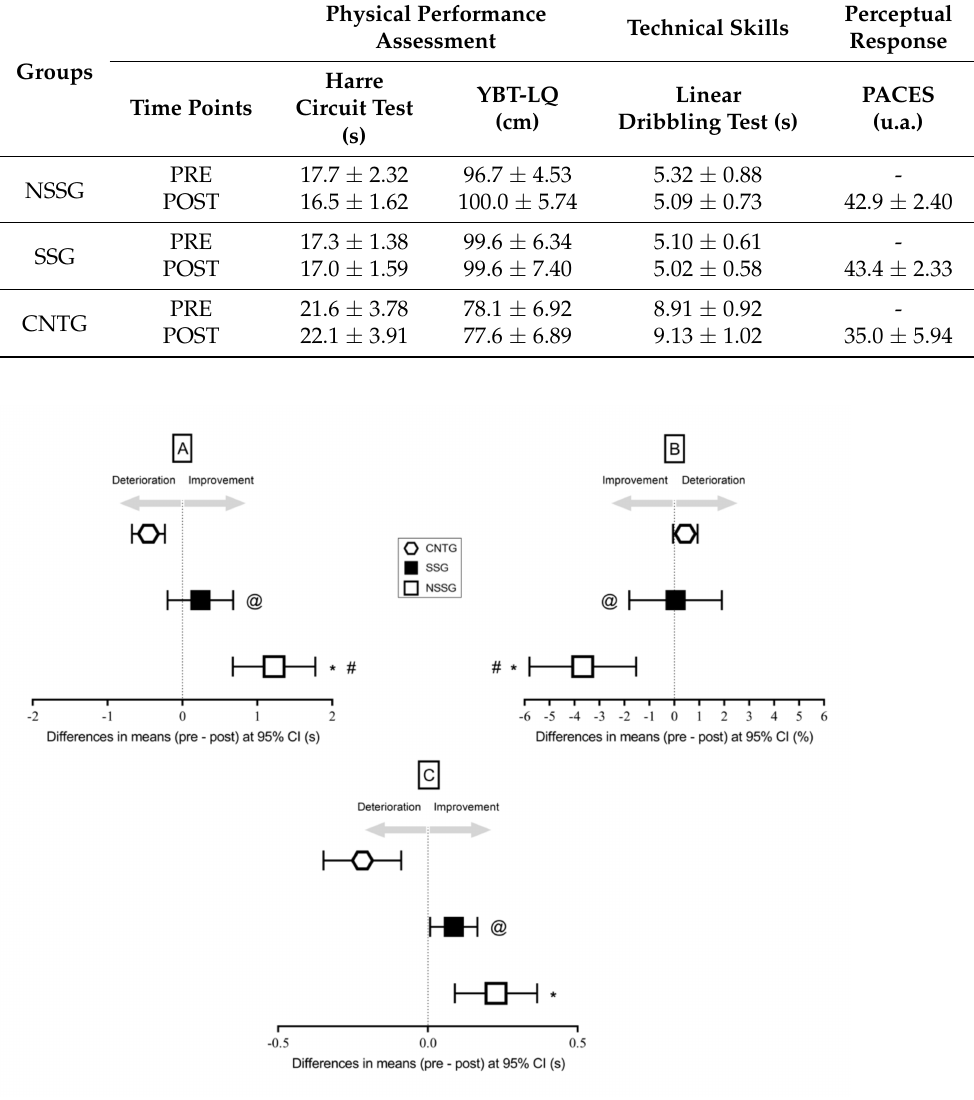
Table 3. Descriptive statistics of the Harre circuit test, Lower Quarter Y-balance test (YBT-LQ), linear dribbling test, and Physical Activity Enjoyment Scale (PACES) for the non-sport-specific group (NSSG), sport-specific group (SSG), and control group (CNTG).